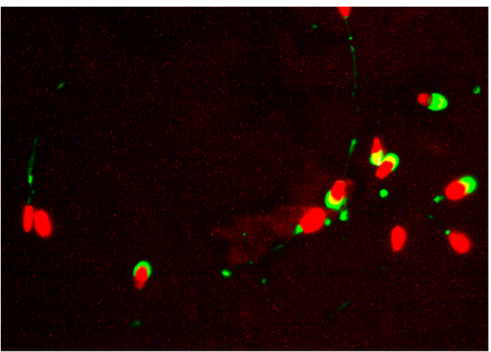
Figure 2. Spermatozoa emitting green fluorescence were regarded as having damaged acrosomes, whereas cells displaying no fluorescence in the acrosome cap were considered to have undamaged, intact acrosomes.